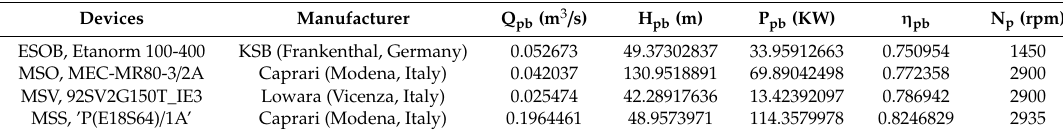
Table 3. Experimental BEP characteristics in pump mode.